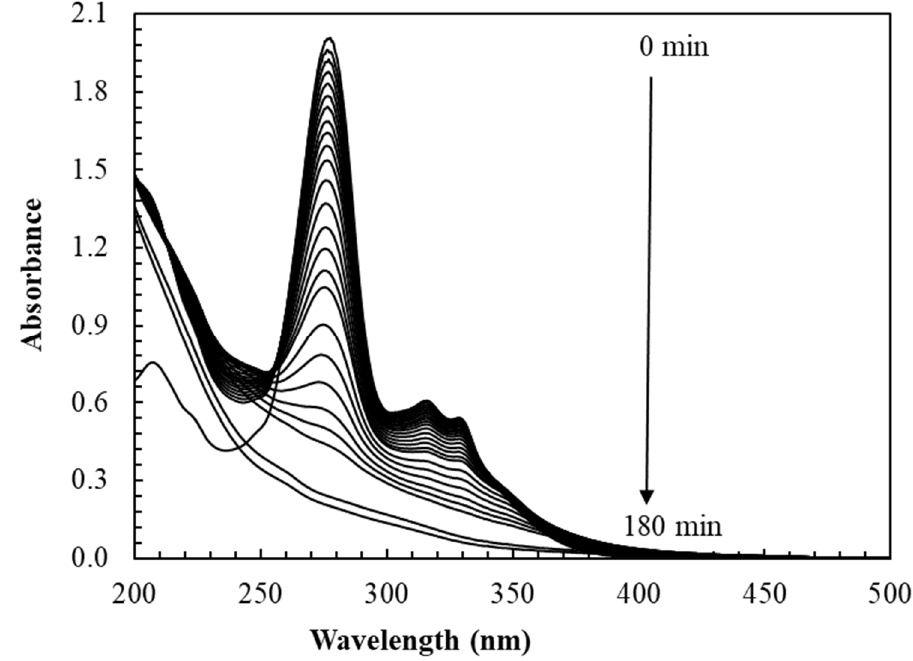
Figure 5. Typical time-resolved spectral changes observed in solar light-assisted oxidative degrada- tion of CPF catalyzed by Fe III -CS-GLA in aqueous solution. Experimental conditions: [CPF] 0 : 50 µM; [Fe III ] 0 in Fe III -CS-GLA: 1.25 mM; [GLA] 0 in Fe III -CS-GLA: 90 mM; [H 2 O 2 ] 0 : 6 mM; volume of CPF solution: 250 mL; pH: 3; light intensity: 70,000–90,000 Lux; solar light irradiation time: 180 min. Table 1. Pseudo-first order rate constants ( k obs ) of CPF degradation by different processes. Degradation Process pH k obs (min –1